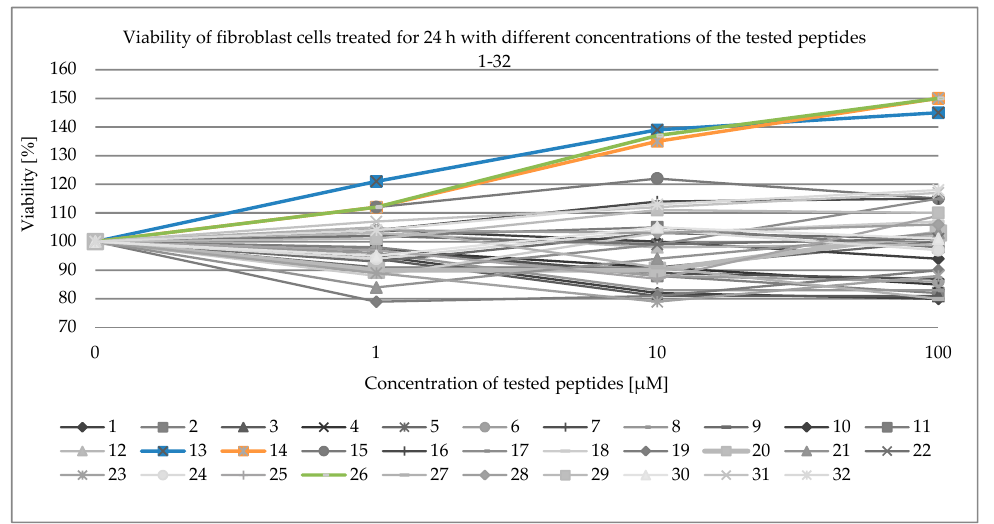
Figure 2. Viability of fibroblast cells treated for 24 h with different concentrations of the tested peptides 1–32 (Table 3).